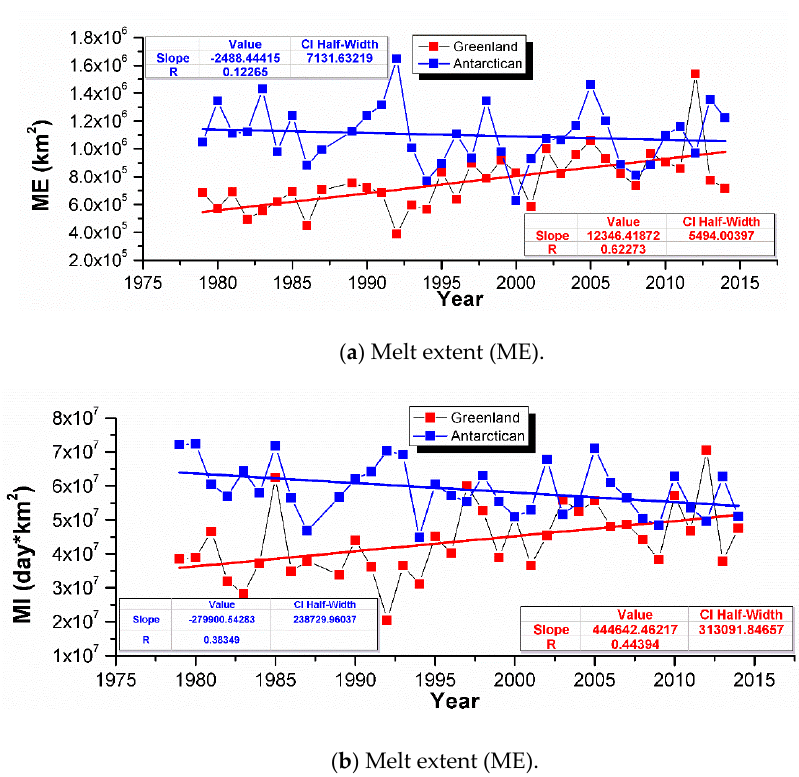
Figure 6. Interannual variation of ( a ) melt extent (ME) and ( b ) melt extent (ME) in Antarctica and Greenland with trend lines fitted for 1978–2014.